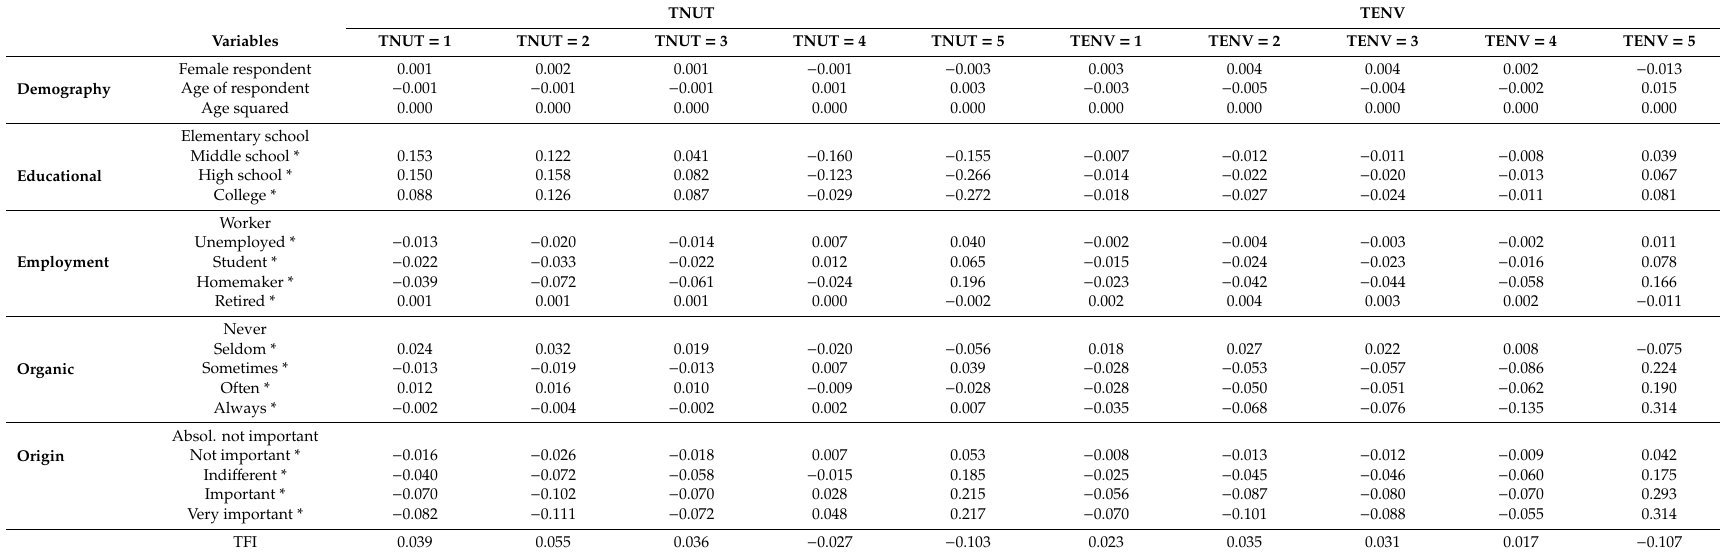
Table 6. Marginal